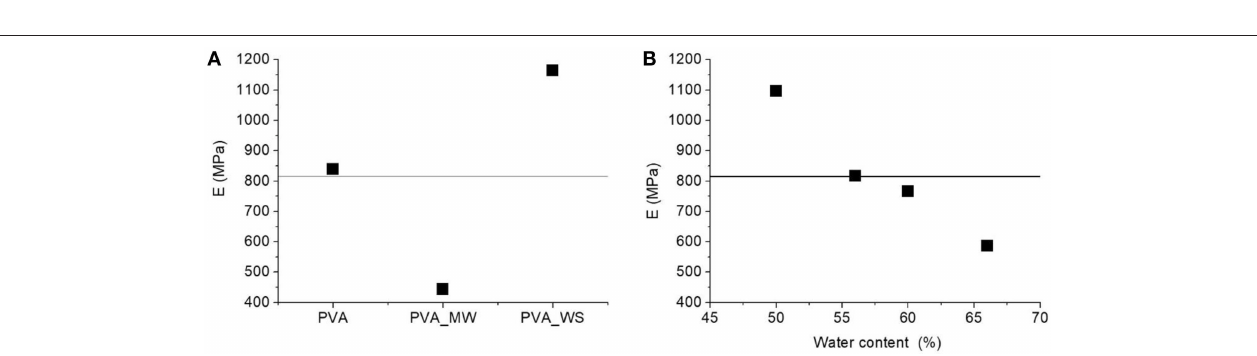
Frontiers in Materials |